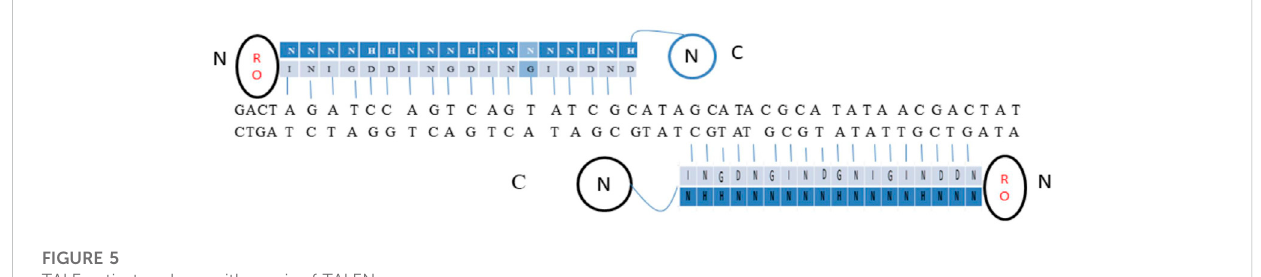
FIGURE 5 TALE activator along with a pair of